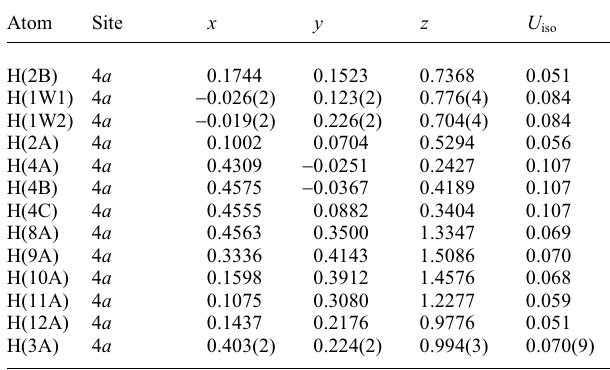
Table 2. Atomic coordinates and displacement parameters (in Å 2 )